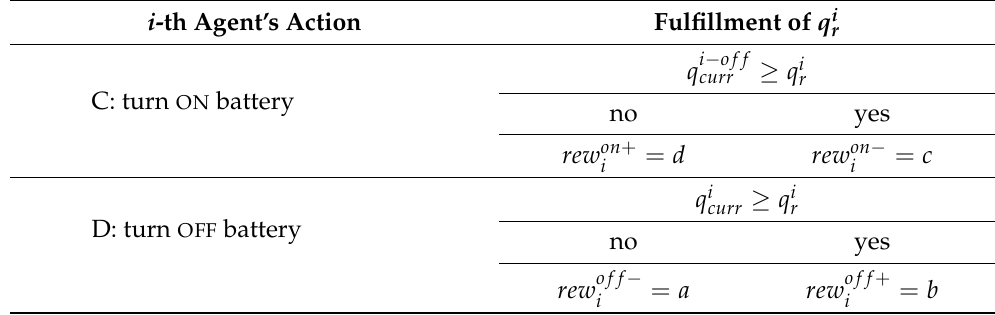
Table 2. Payoff function of SPD-like game to solve WSN coverage and lifetime optimization problem.